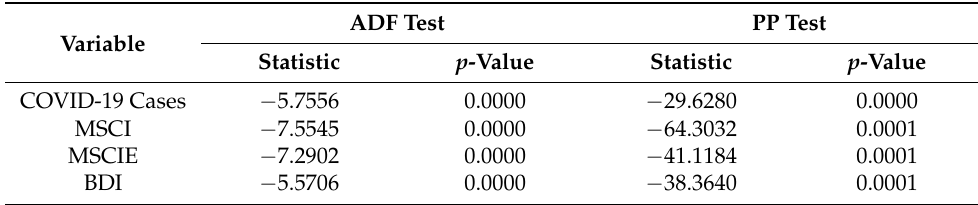
Table 3. Unit root